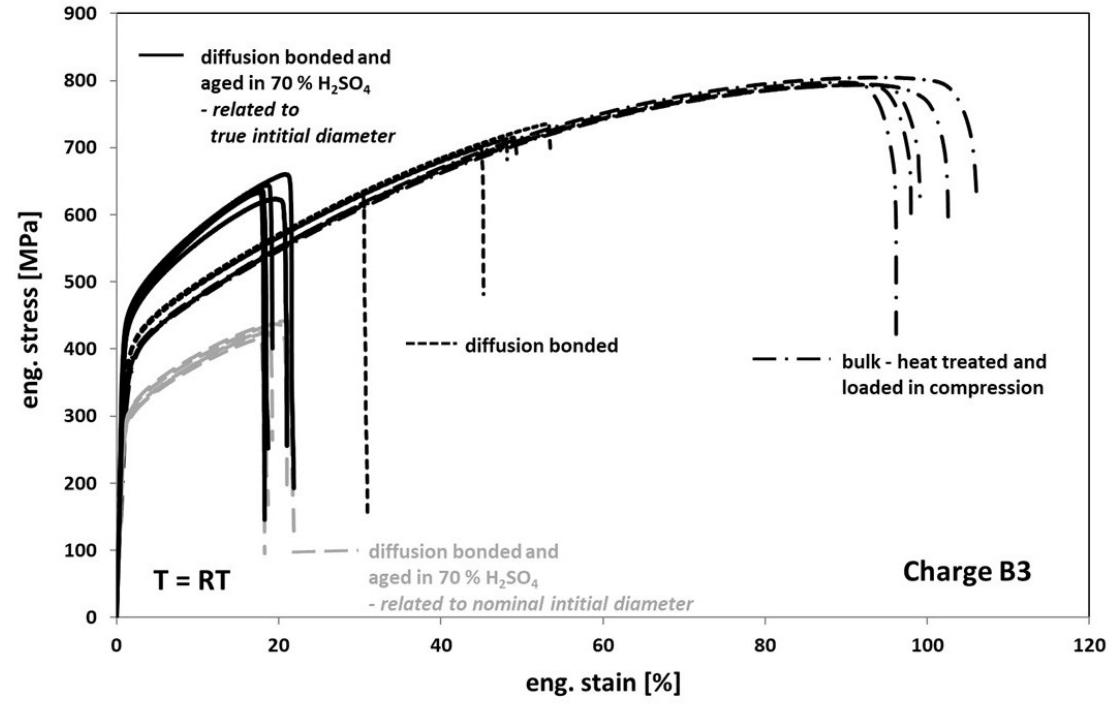
Figure 10. Tensile response of Hastelloy B3 in different conditions.